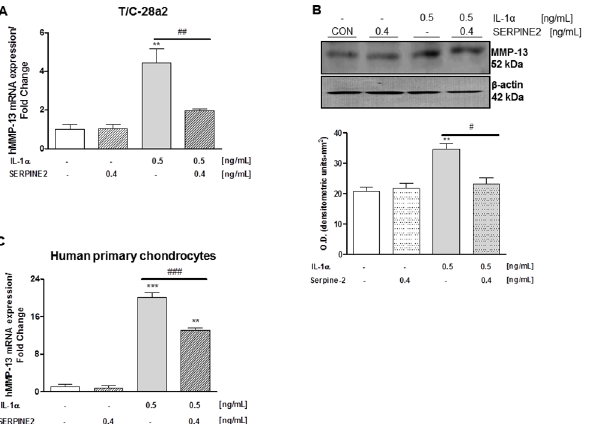
(0.4 ng/mL) in presence or not of IL-1 α (0.5 ng/mL) for 24 h. B. Representative western blot of human MMP- 13 protein expression in lysates obtained from T/C-28a2 chondrogenic cells treated with with